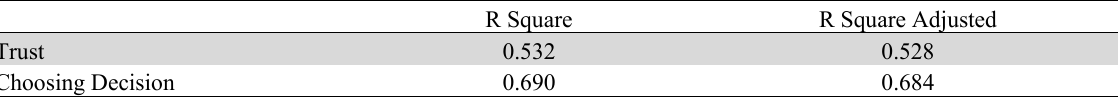
Evaluating Model Based on R Square